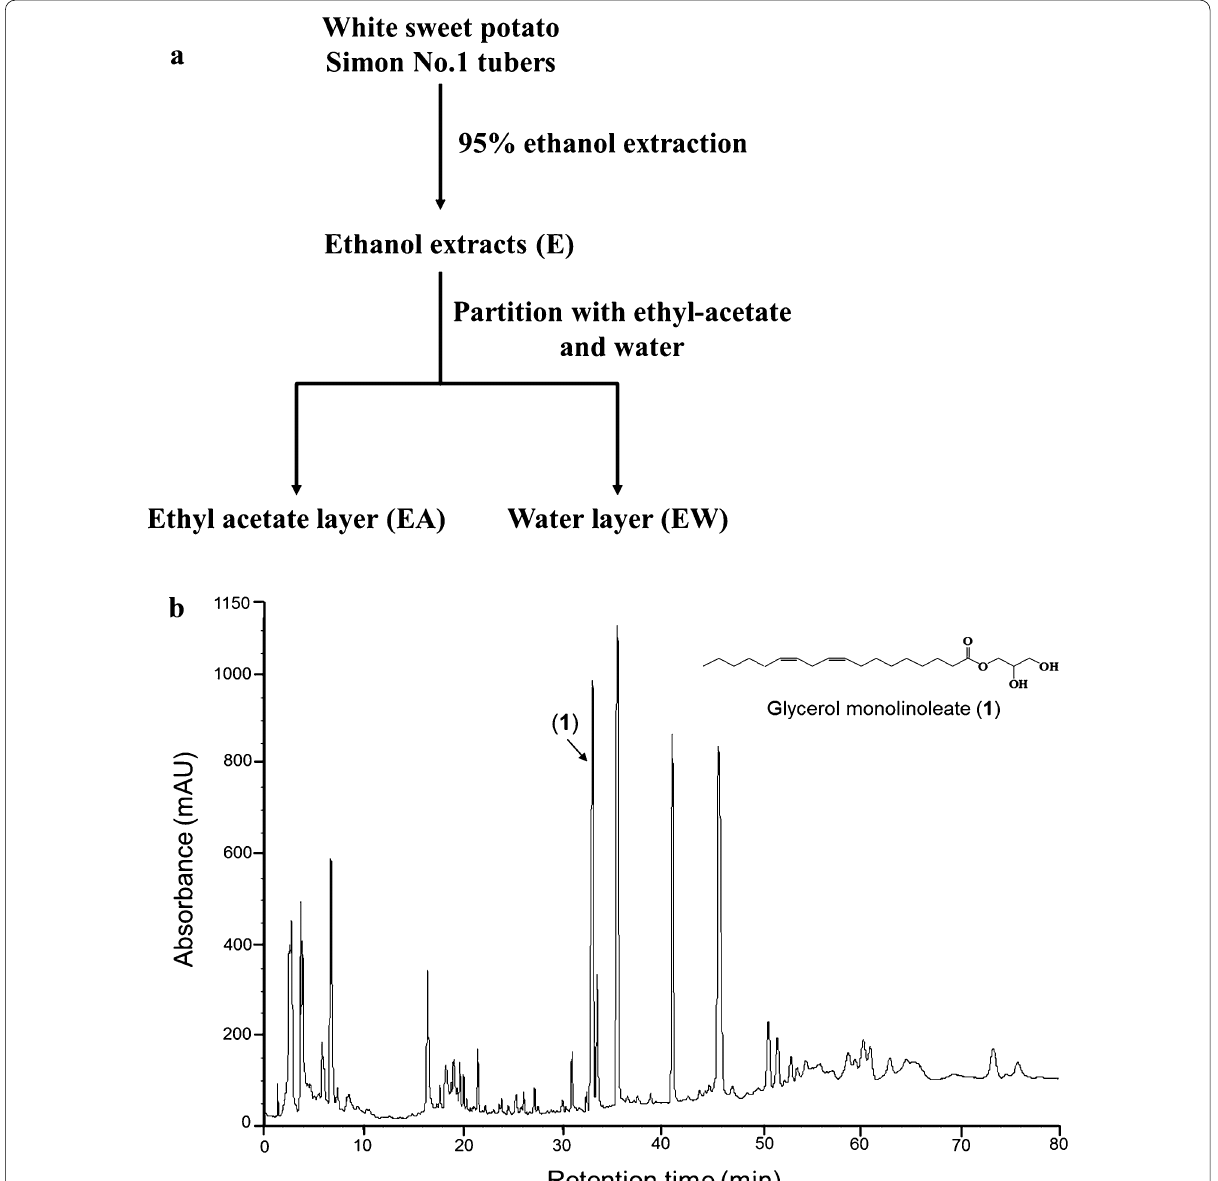
Fig. 1 Methods for the preparation of white sweet potato tuber extracts ( A ). HPLC analysis of the most bioactive WSP‑EA fraction ( B